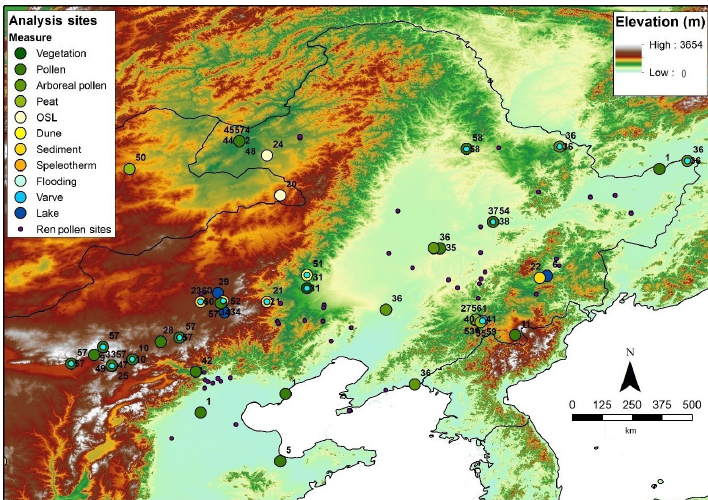
Figure 8. 4.2kaBP Event analysis sites by type of evidenced measured (numbered site information can be found in the online data archive). Note the lack of sites in the northern portion of the region (Heilongjiang Province and NE inner Mongolia). Light blue dots within individual measures indicate sites with no change across the 4.2kaBP Event. Small purple dots are pollen sites from Ren and Zhang (1998) derived from published work and unpublished dissertations. While not all sites cover the 4.2kaBP Event, we include the Ren and Zhang data to show the distribution of late Holocene paleoclimatic reconstruction work in NE